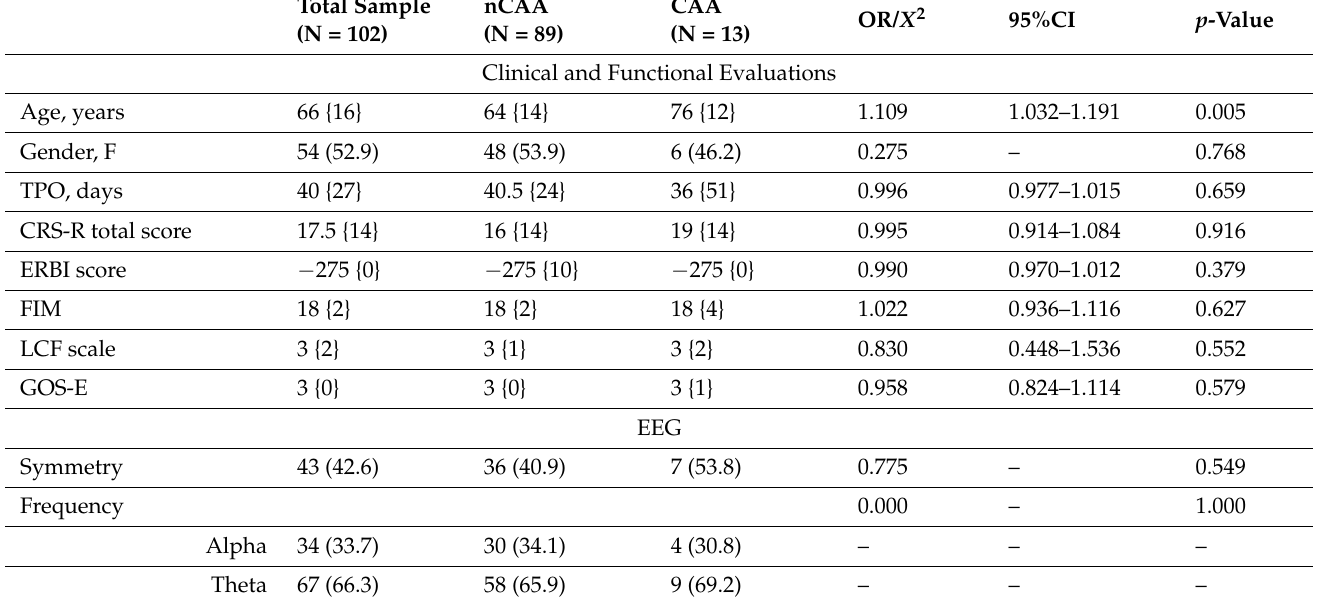
Table 1. Characteristics of the study sample upon